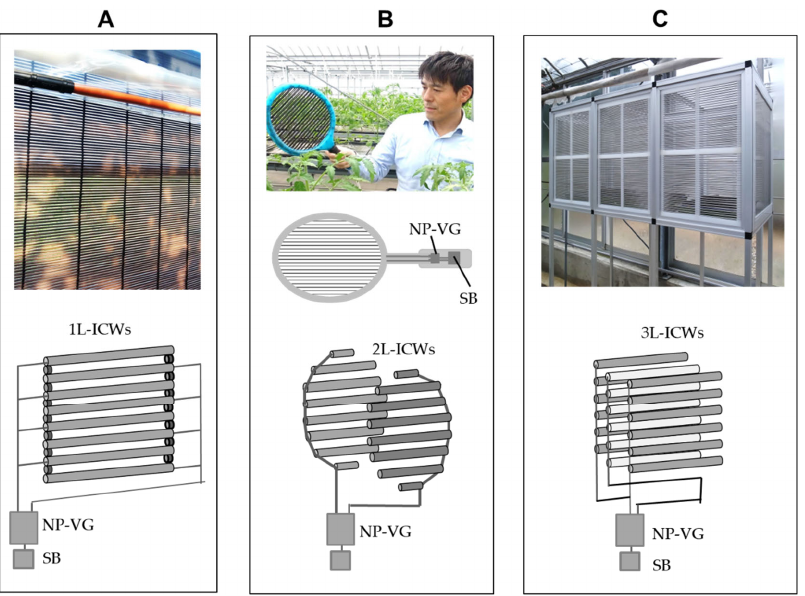
Figure 16. Photographs and schematic representation of a bamboo blind ‐ shaped 1L DD screen ( A ) [8], an electrostatic flying insect catcher (2L DD screen) ( B ) [41], and an electrostatic seedling shelter (3L DD screen) ( C ) [42]. NP ‐ VG, negative and positive voltage generators in one box; SB, storage battery. DD screen) ( C ) [42]. NP-VG, negative and positive voltage generators in one box; SB, storage